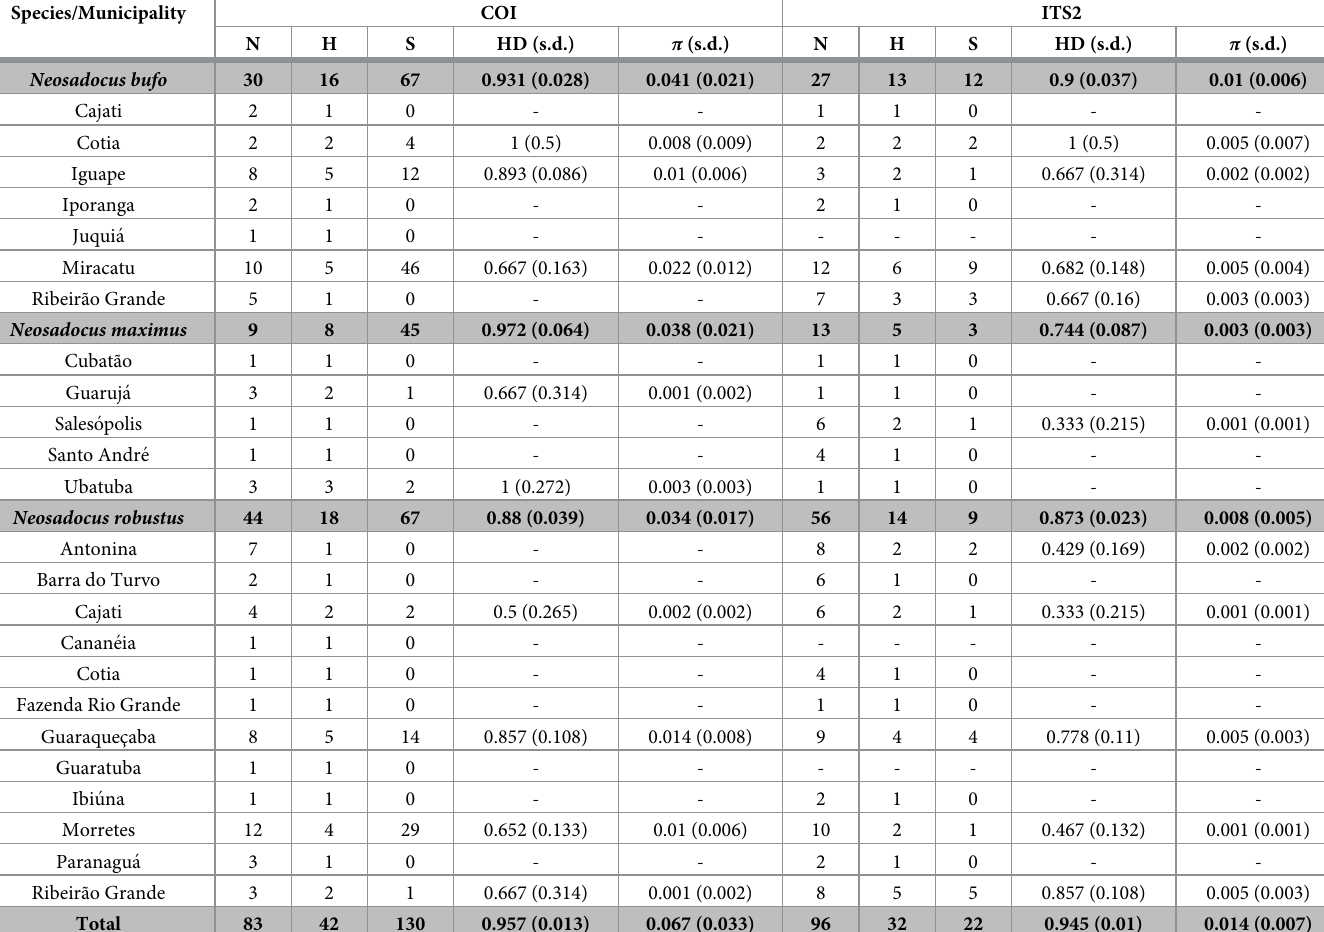
Table 2. Haplotype and nucleotide diversities for each Neosadocus species (gray lines) and per location (under species indices).